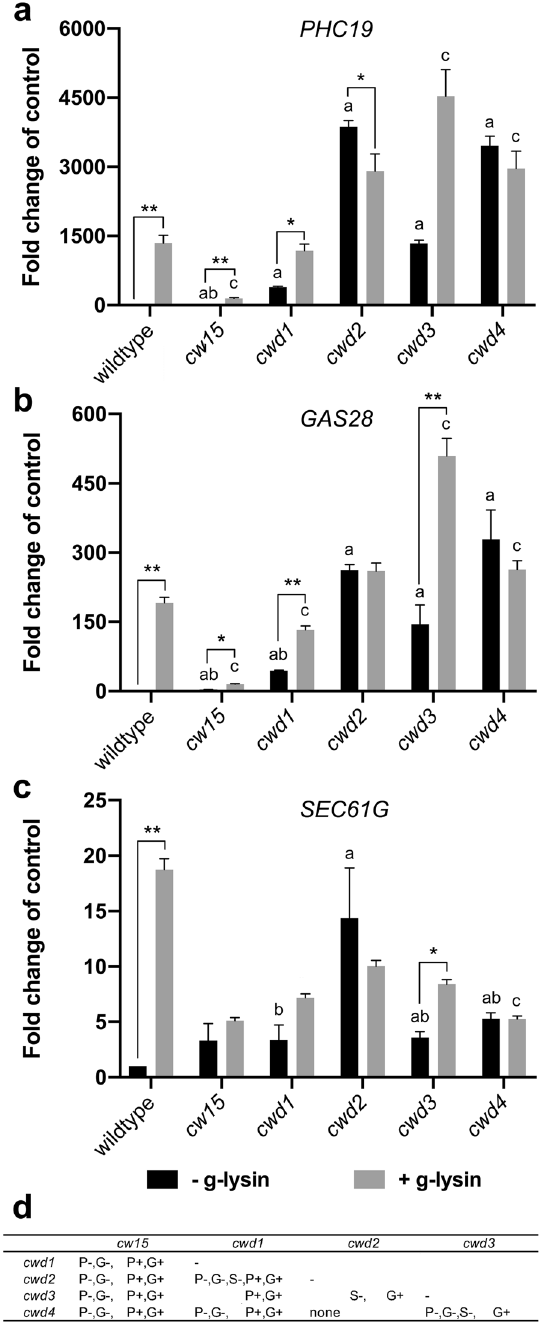
Figure 6. CW genes are constitutively activated in cell wall defective mutants. ( a – c ) Bar graphs represent the change in gene expression by g-lysin treatment for PHC19 ( a ), GAS28 ( b ), and SEC61G ( c ) in wildtype (CC- 125), cw15 , cwd1 , cwd2 , cwd3 , and cwd4 . Untreated gamete control samples represented by black bars, − g-lysin; medium grey bars for g-lysin-treated cells, + g-lysin. Gene expression is quantified in terms of fold change of the untreated wildtype cells. Error bars represent one standard deviation from the mean of biological triplicate samples. Asterisks indicate a significant difference between − g-lysin and + g-lysin cells using a two-way ANOVA at p ≤ 0.05 ( * ), p ≤ 0.01 ( ** ); α = 0.05. Letters above error bars indicate a significant difference relative to the − g-lysin wild-type (‘a’) or the + g-lysin wild-type (‘b’ or ‘c’) cells using a two-way ANOVA (p ≤ 0.01; α = 0.05). ( d ) Statistical tests of difference in cell wall gene expression among the cwd mutants. Two-way ANOVA results (p ≤ 0.01; α = 0.05) between mutants given in the row and column headers are summarized for three cell wall genes (P, G, and S for PHC19 , GAS28 , and SEC61G ) in -g-lysin cells (‘ − ’ sign) or in + g-lysin cells (‘ + ’